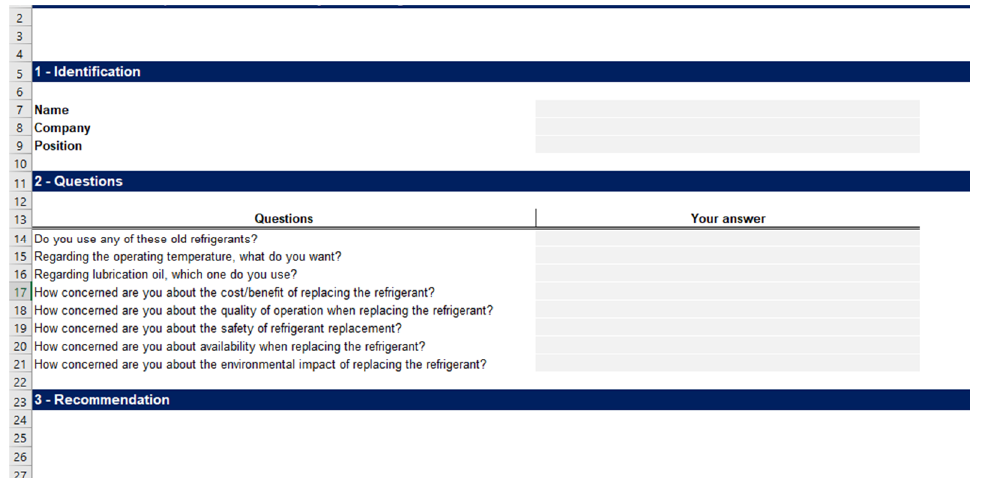
Figure 1. Decision support tool layout.